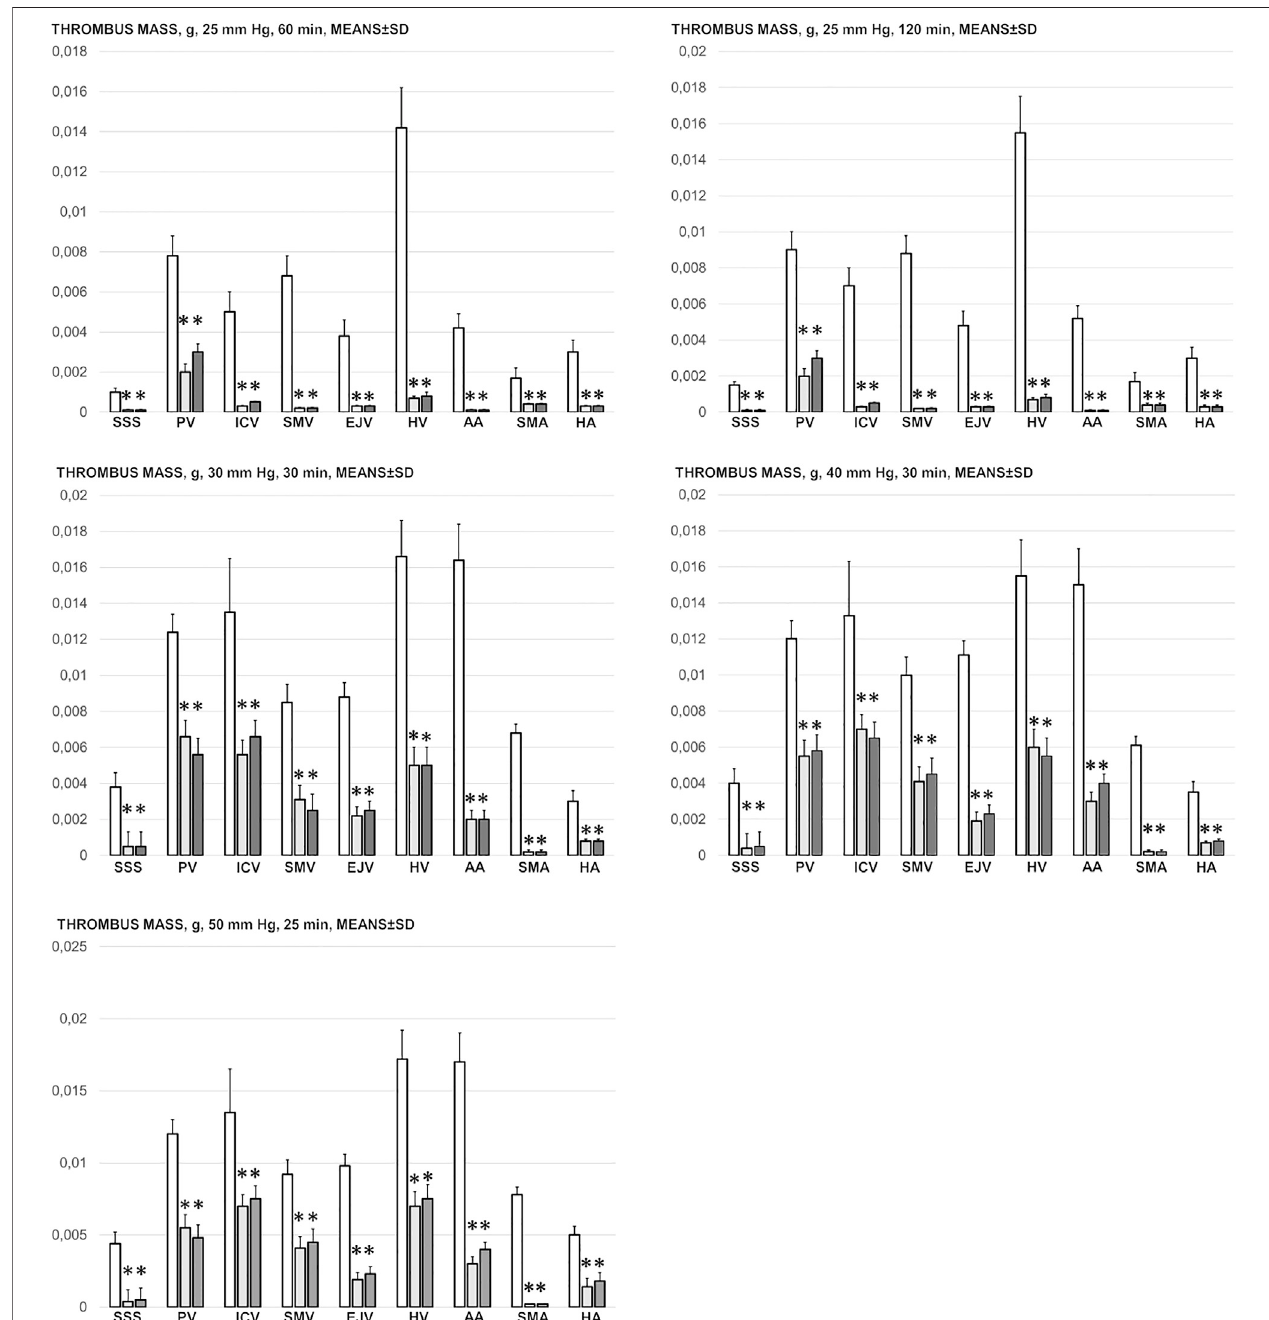
FIGURE 6 | Thrombus mass, g (in the superior sagittal sinus (SSS), portal vein (PV), inferior caval vein (ICV), superior mesenteric vein (SMV), external jugular vein (EJV), hepatic veins (HV), abdominal aorta (AA), superior mesenteric artery (SMA) and hepatic artery (HA)) in the thiopental-anesthetized rats with the increased intra- abdominal pressures at 50 mmHg for 25 min, at 30 mmHg or 40 mmHg for 30 min, at 25 mmHg for 60 min increased intra-abdominal pressures-time and in the esketamine-anesthetized rats with the increased intra-abdominal pressures at 25 mmHg for 120 min increased intra-abdominal pressures-time, following medication (BPC 157 10 μ g/kg (light gray bars), 10 ng/kg (dark gray bars); saline 5 ml/kg (white bars)) given subcutaneously at 10 min increased intra-abdominal pressures-time. Means ± SD, *P ˂ 0.05, vs. control.